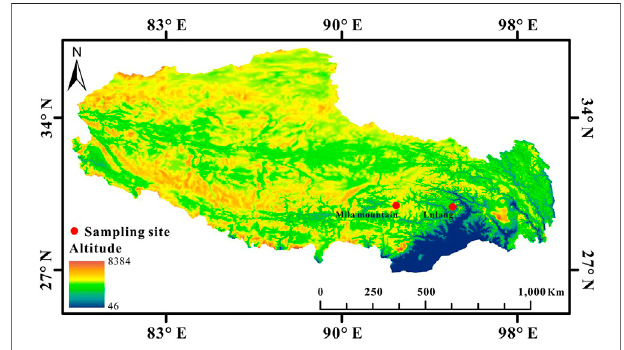
FIGURE1| Samplingsitesofhigh-altitude (4,600 m,Milamountain)and low-altitude (3,400 m, Lulang) N. parkeri on the Qinghai-Tibet Plateau (Map source: http://westdc.westgis.ac.cn/).